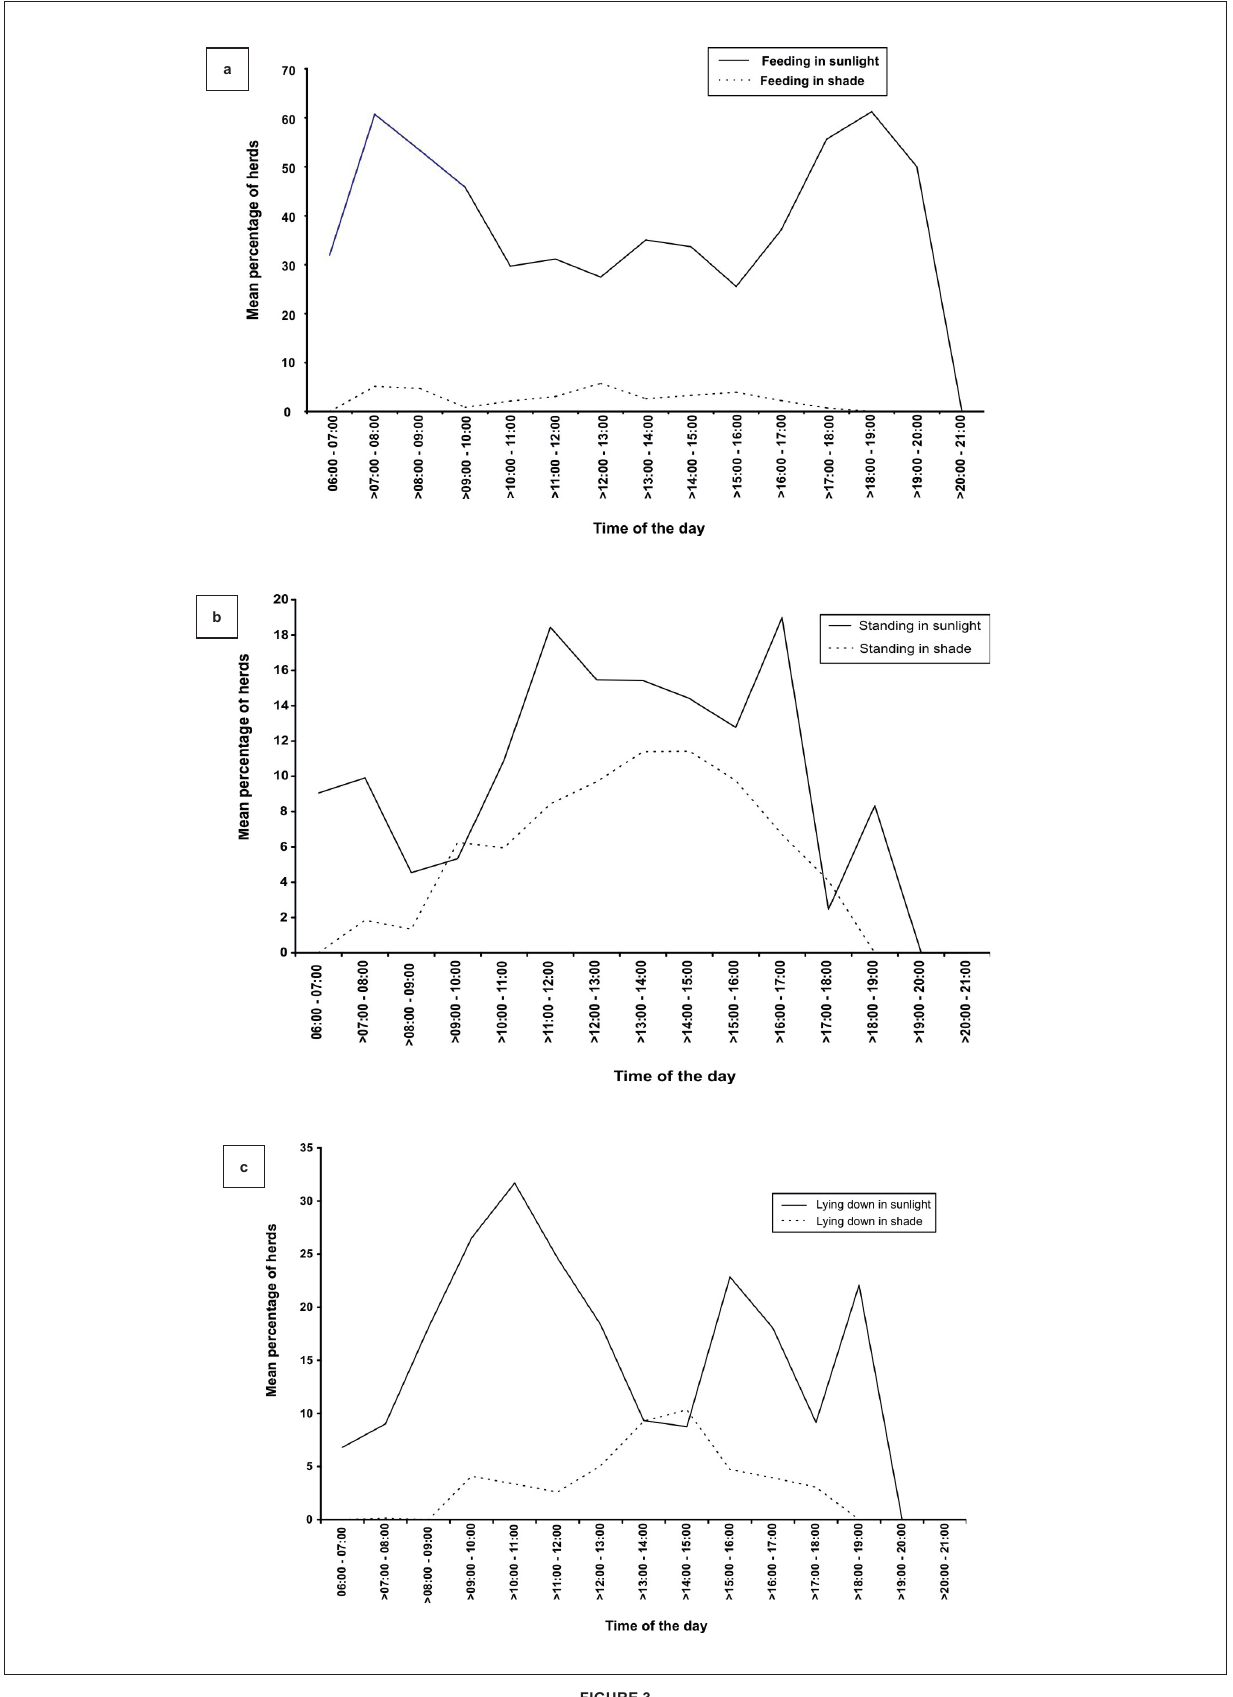
Figure 3 Mean percentage of springbok per herd involved in different activities at hourly intervals during the study period from November 2002 to May 2004 in the Kalahari Gemsbok National Park. (a) Feeding in sunlight and shade, (b) standing in sunlight and shade, (c) lying down in sunlight and